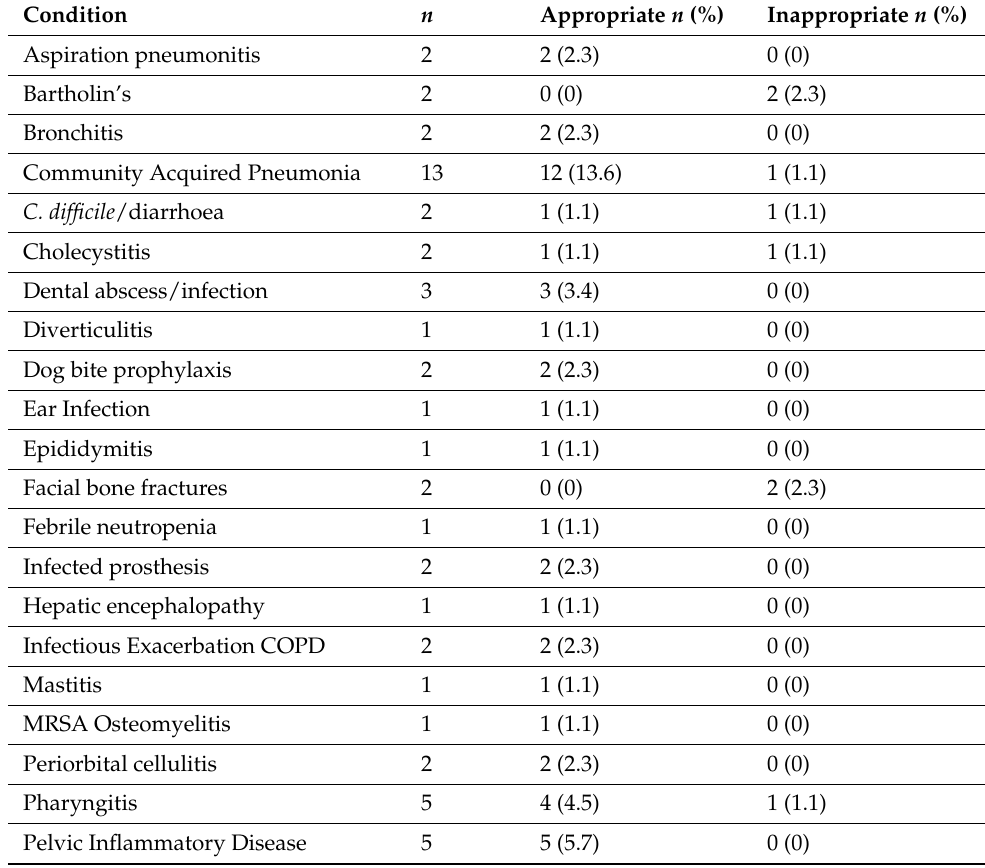
Table A2. Conditions for which antibiotic medications were